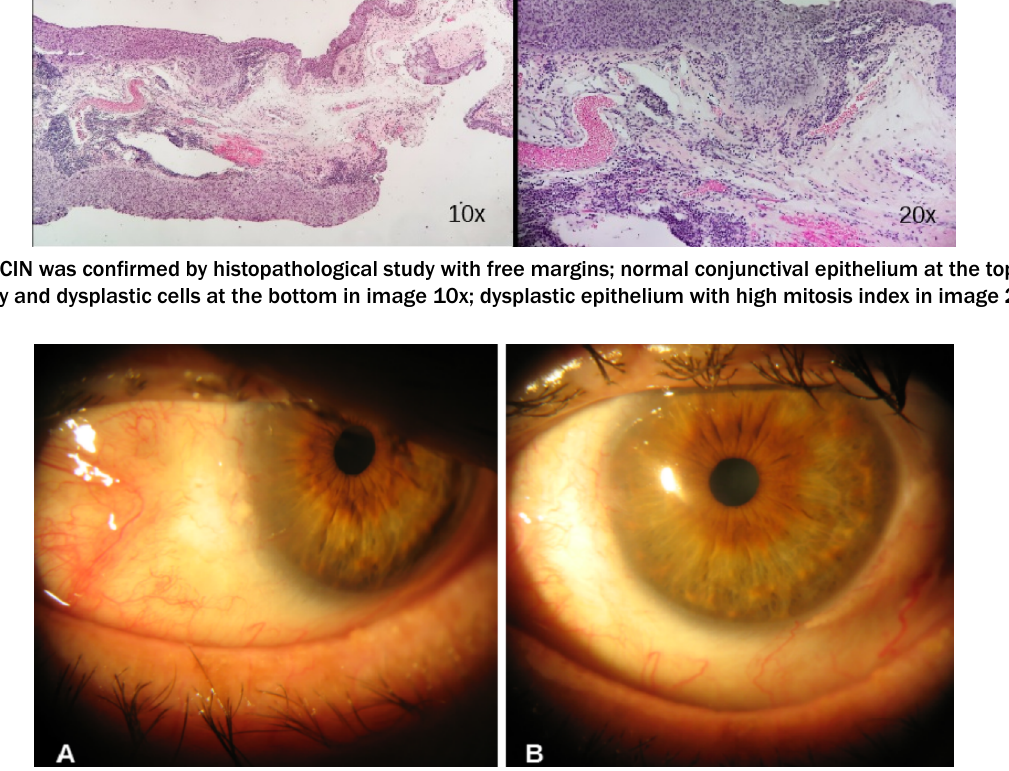
Figure 3: A) One month later, the lesion had decreased. B) At the third month, CIN had disappeared.